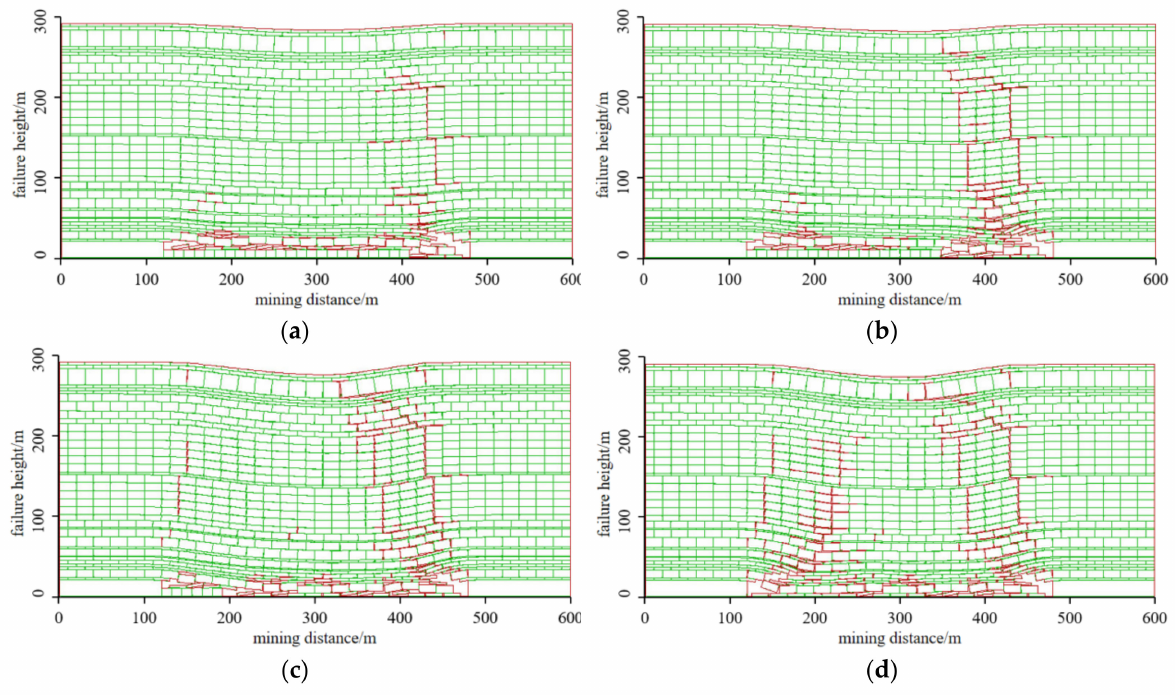
Figure 9. Fracture distribution of overburden under the extraction of the second slice with the working face advancing to: ( a ) 72 m (the second slice); ( b ) 132 m (the second slice); ( c ) 288 m (the second slice); ( d ) 360 m (the end of the extraction of the second